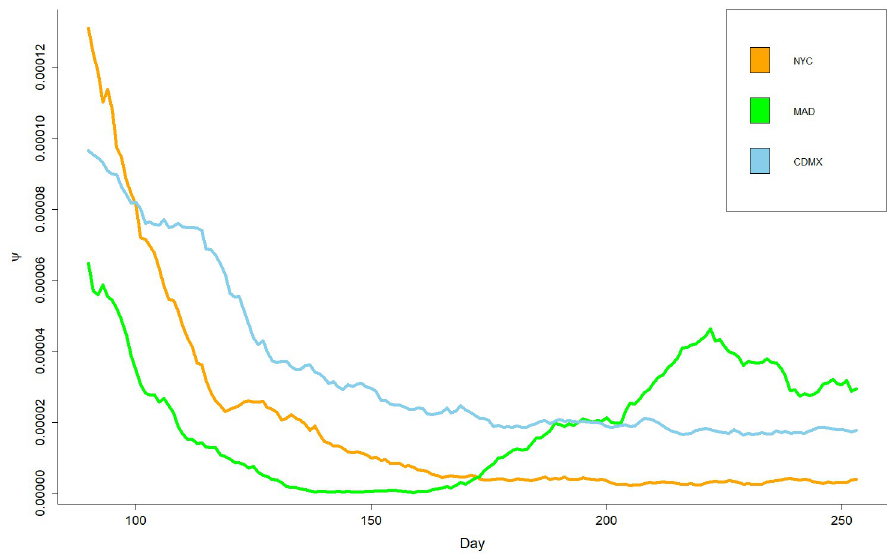
Fig 2. Visual representation of indicator ψ for the investigated period, from May 21st to October 31st, 2020.